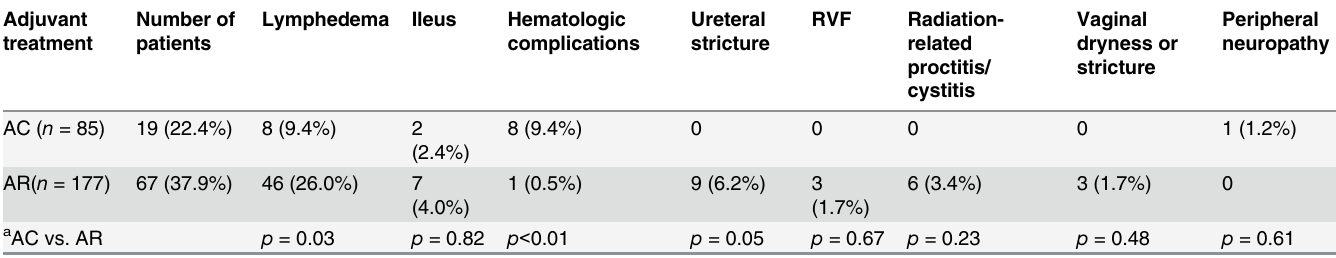
Table 6. Adverse effects of adjuvant